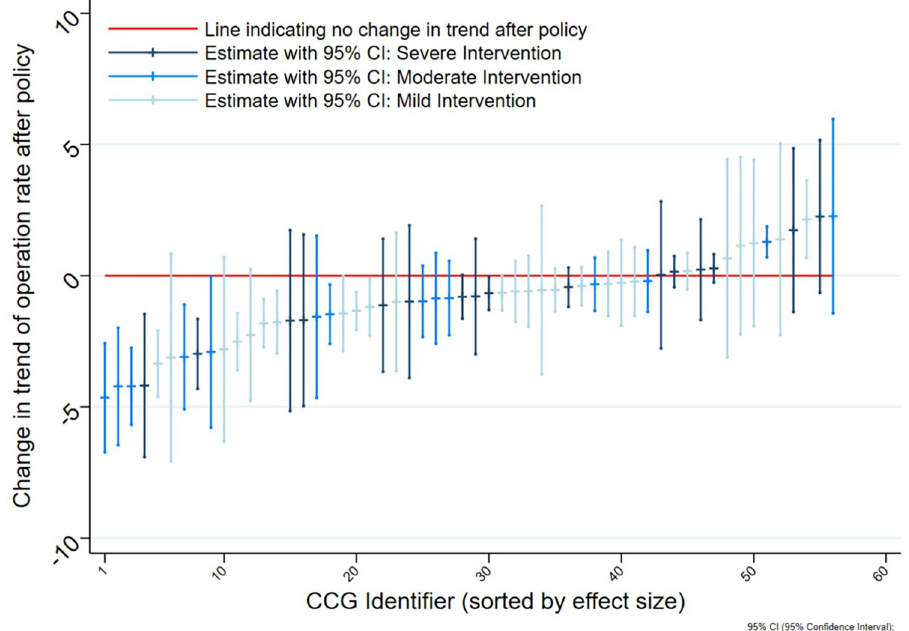
Fig 1. Caterpillar plot of effect size in CCGs with policies of any severity n = 56 (‘effect size’ is regression model coefficient for change in pre- to post- policy introduction trends in rate of knee arthroplasty operations per 100,000 population aged 40+, per